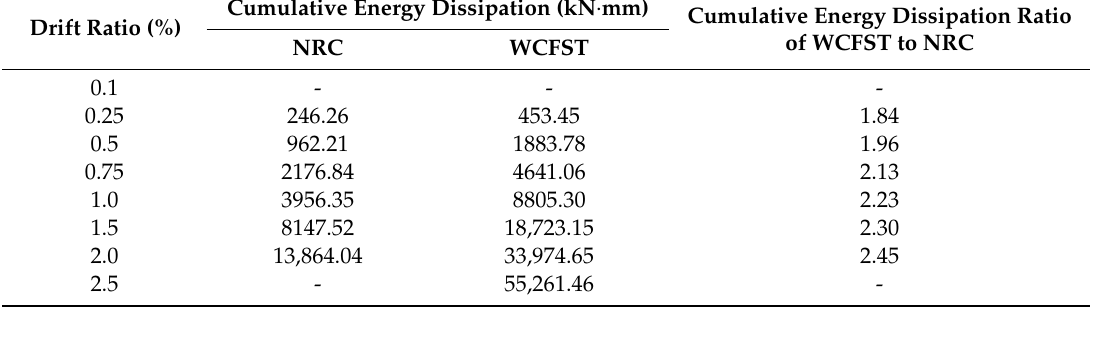
Table 5. Comparison of cumulative energy dissipation according to the drift ratio. Drift Ratio (%)